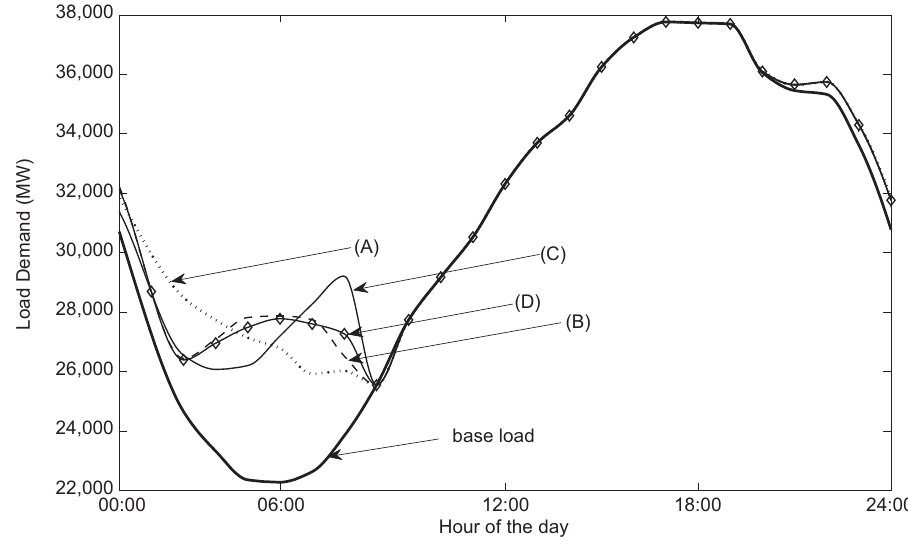
Figure 11. Load profiles for Table 3 algorithms.